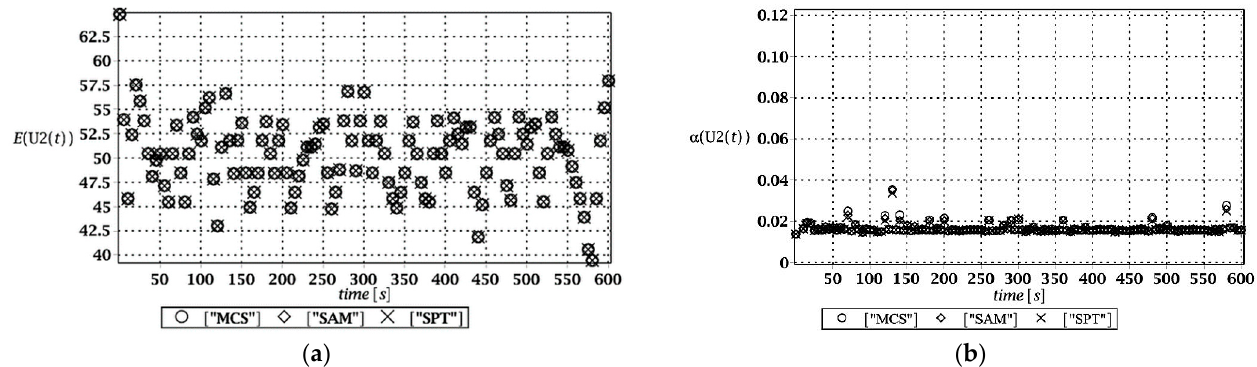
Figure 5. ( a ) The expectation of vertical displacement at the ridge of frame for stochastic wind pressure; ( b ) its coefficient of variation.